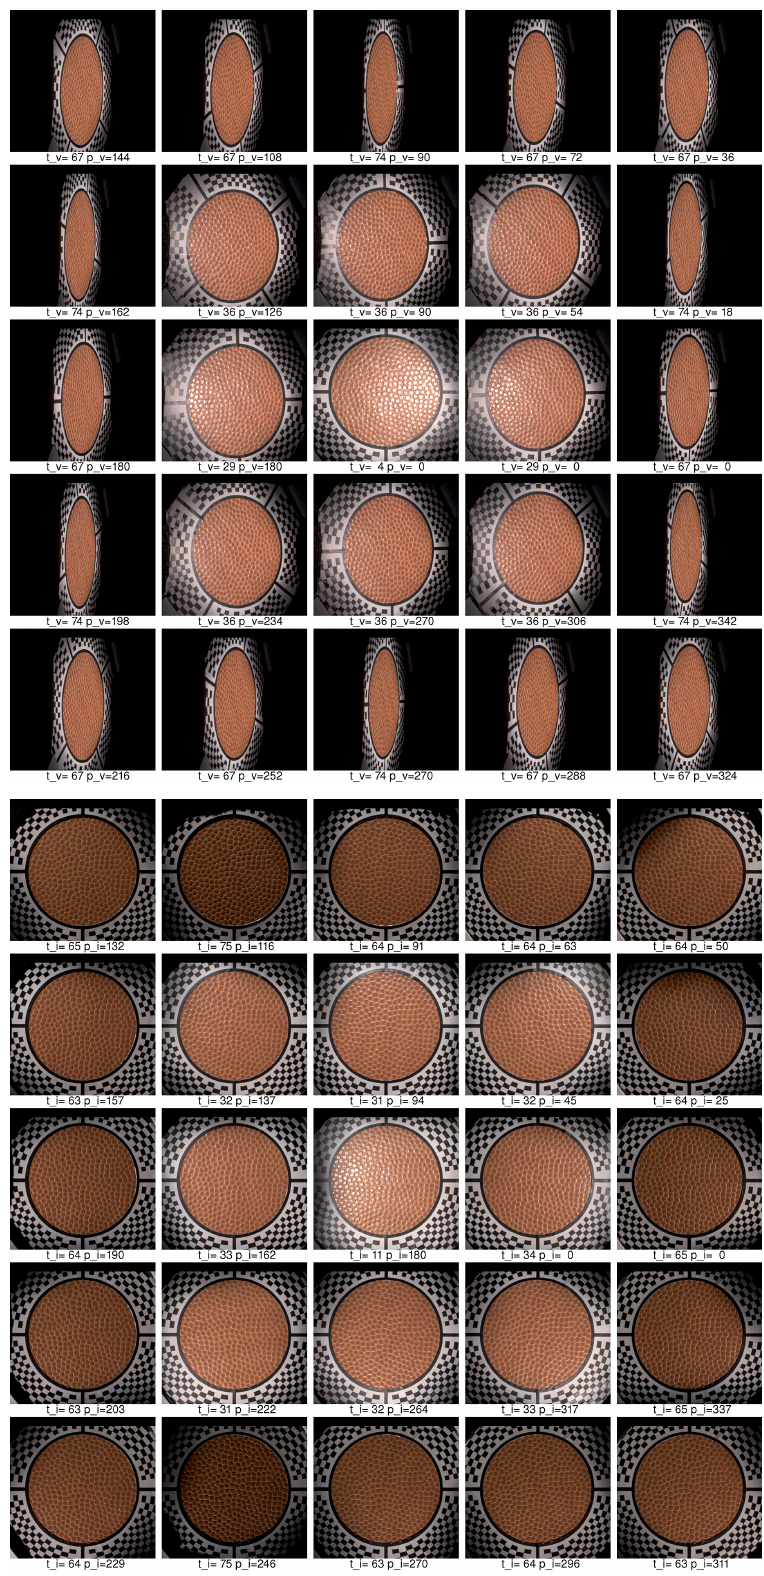
Figure 23. The example measurement data on example material sample 009-Basketball from The MAM 2014 sample set ([35]). ( top ) changing the viewing direction for illumination direction close to the normal for θ i = 12.5 ◦ ; ( bottom ) changing the illumination direction, the camera at direction θ v = 3.5 ◦ , φ v = 1 ◦